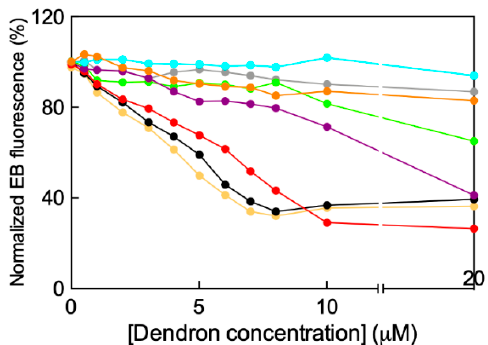
Figure A1. Experimental determination of siRNA binding to self-assembling dendrons 1 (gray), 2 (light green), 3 (purple), 4 (red), 5 (black), and 6 (yellow) by EB assay. Non-self-assembling dendrons 7 (cyan) and 8 (orange) were used as negative controls. Adapted from [7] with the permission of John Wiley and Sons, 2016.